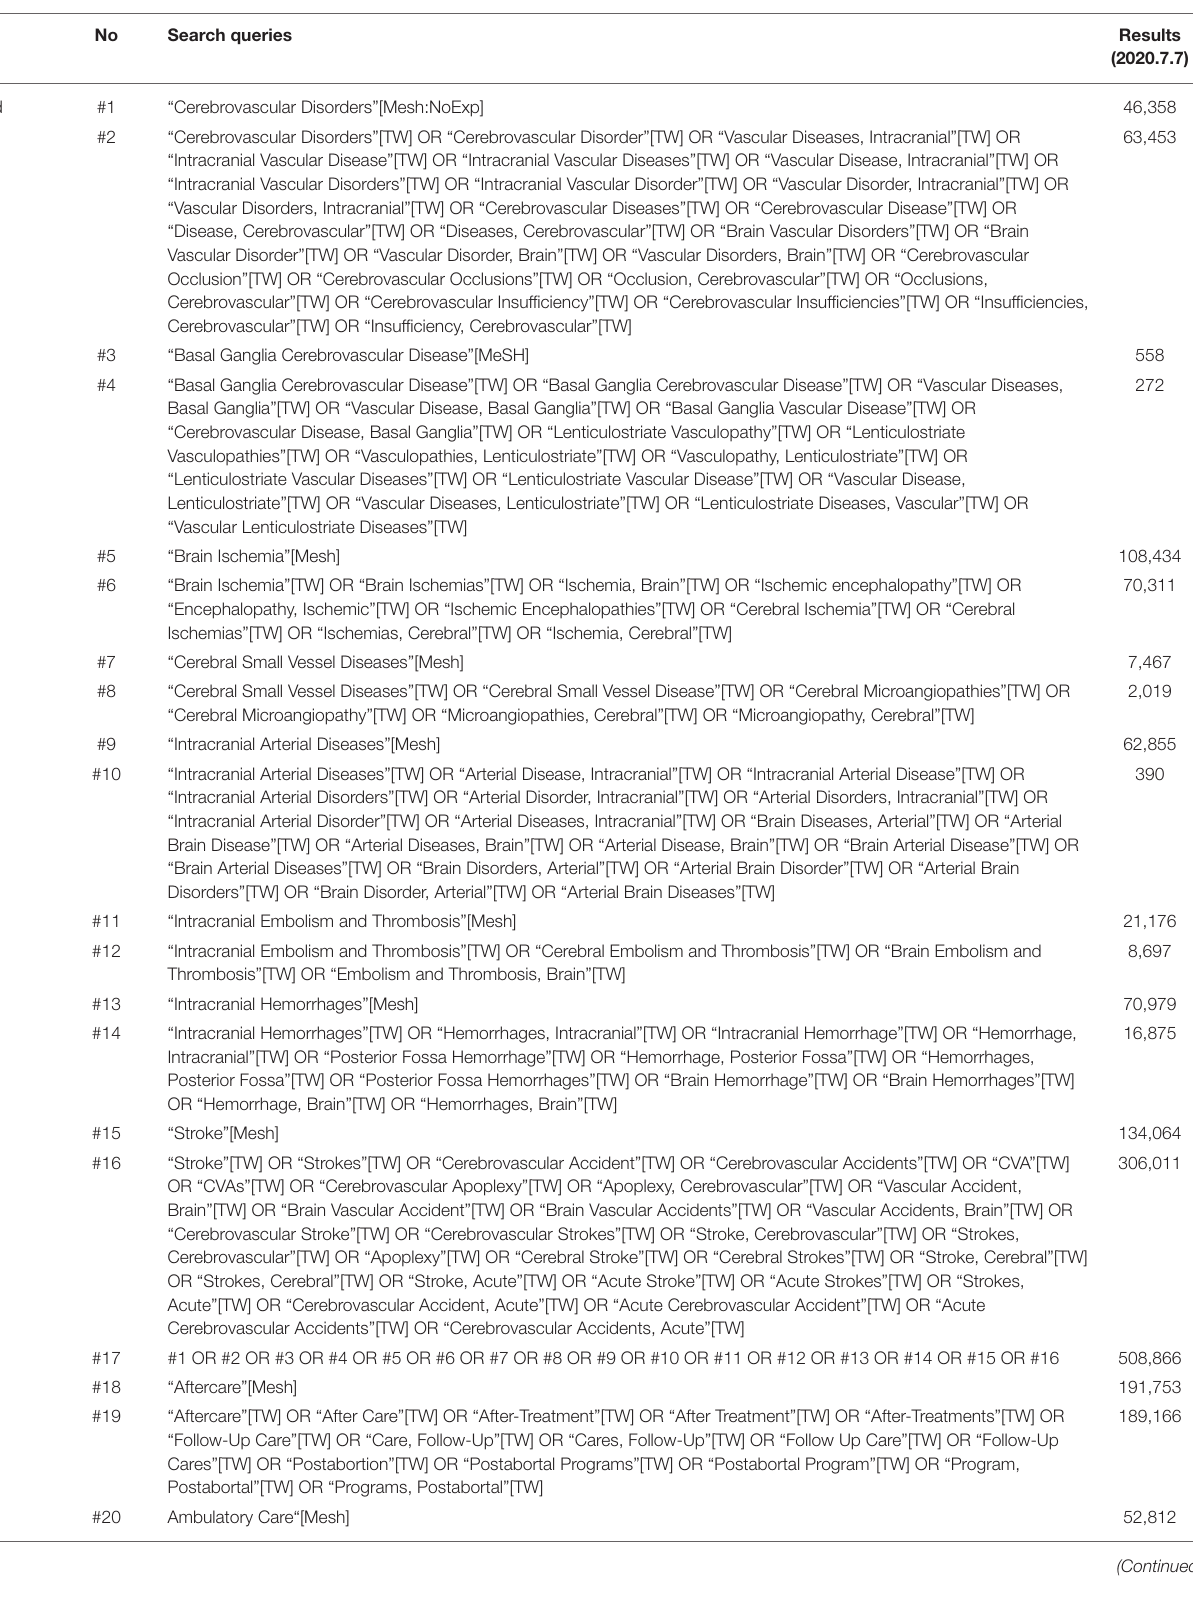
TABLE 1 | Search strategy according to the searching engine and